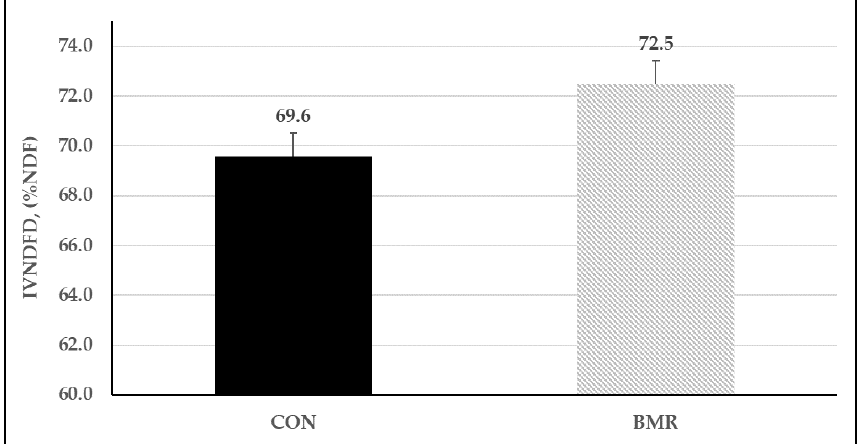
Figure 2. In vitro NDF digestibility (IVNDFD) of pearl millet genotypes planted at two different dates (May 9th and May 18th) and harvested three times during 2018 (Trial 1). Gen ( p < 0.01), planting date ( p = 0.60), and Gen × planting date ( p = 0.28); vertical bars indicate standard errors of the mean.